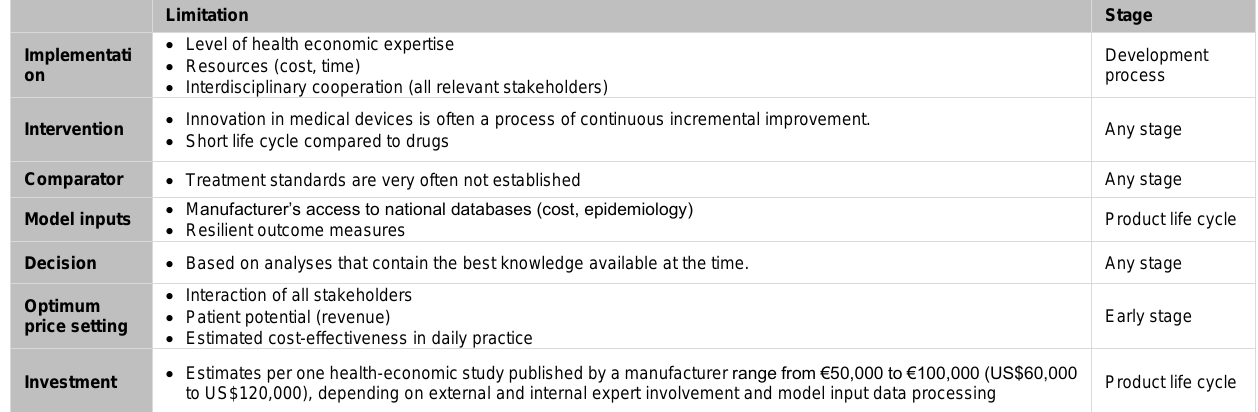
Table 3: Limitations to health-economic modeling and analyses in the development process and product life